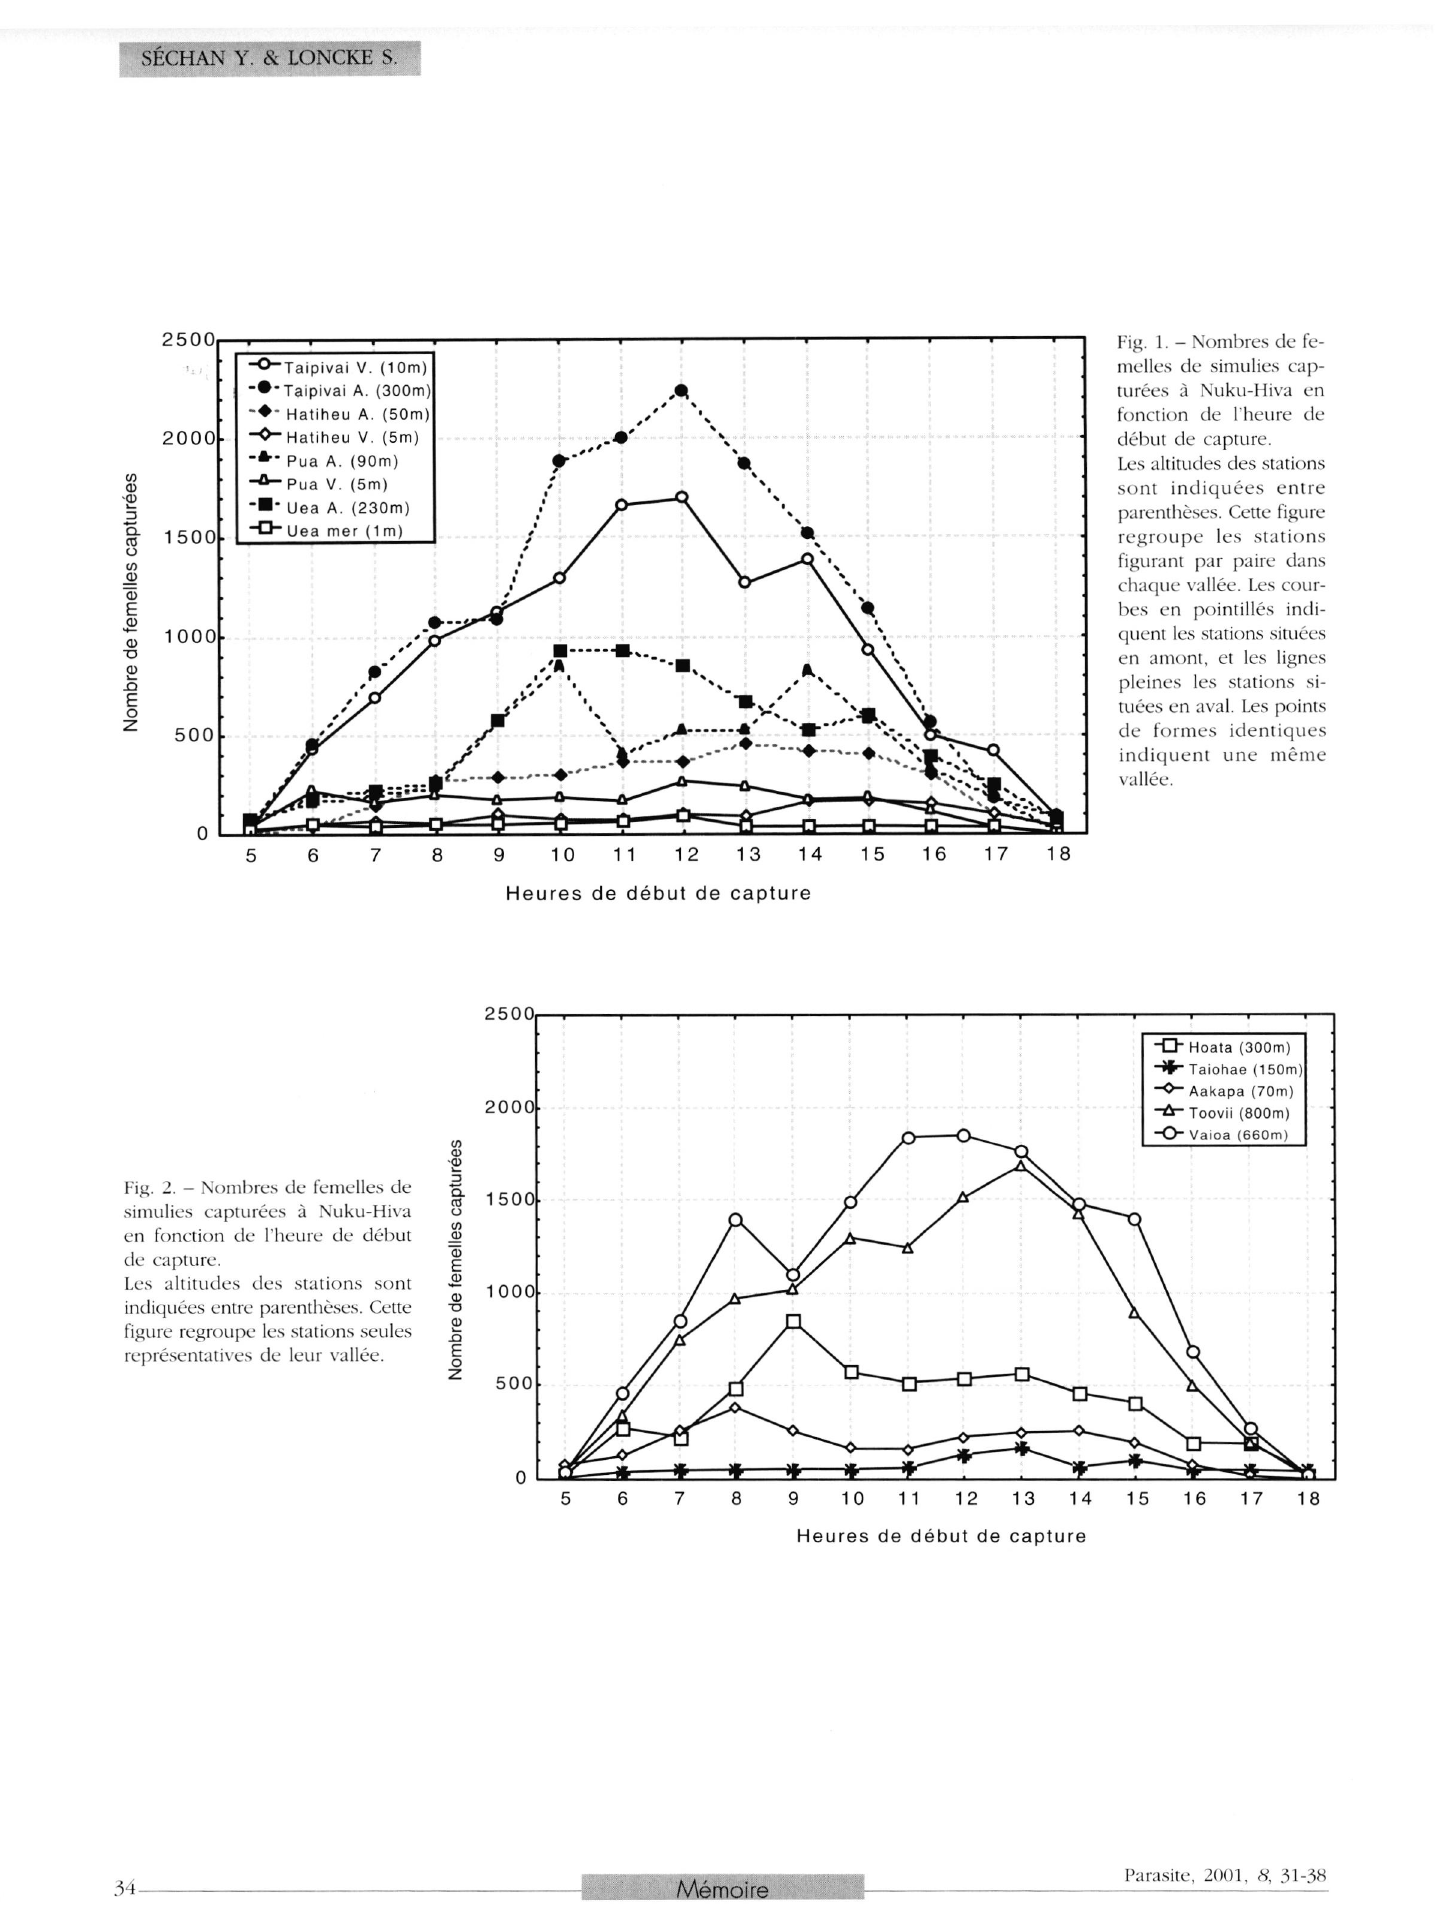
Fig. 2. - Nombres de femelles de simulies capturées à Nuku-Hiva en fonction de l'heure de début de capture. Les altitudes des stations sont indiquées entre parenthèses. Cette figure regroupe les stations seules représentatives de leur